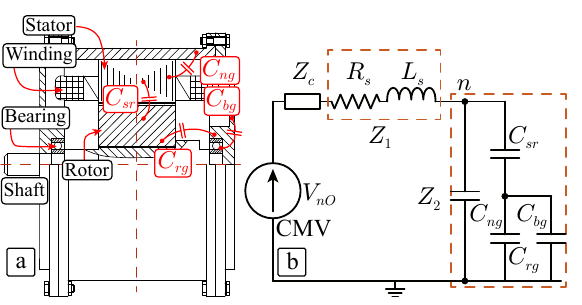
Figure 3. ( a ) PMSM machine section. ( b ) Equivalent impedance model of a PMSM